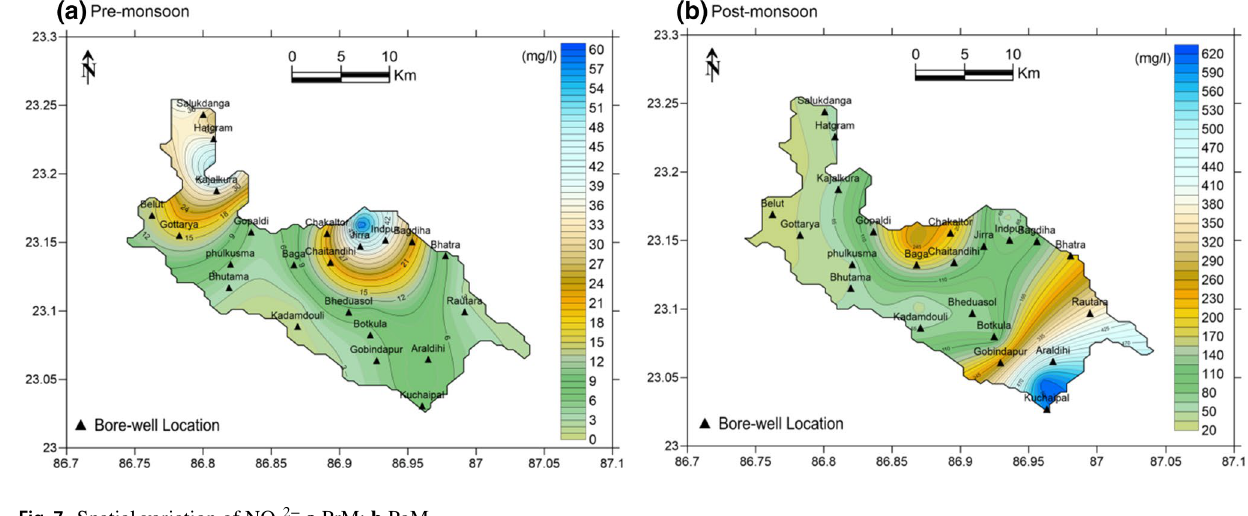
Fig. 7 Spatial variation of NO 32− a PrM; b PoM